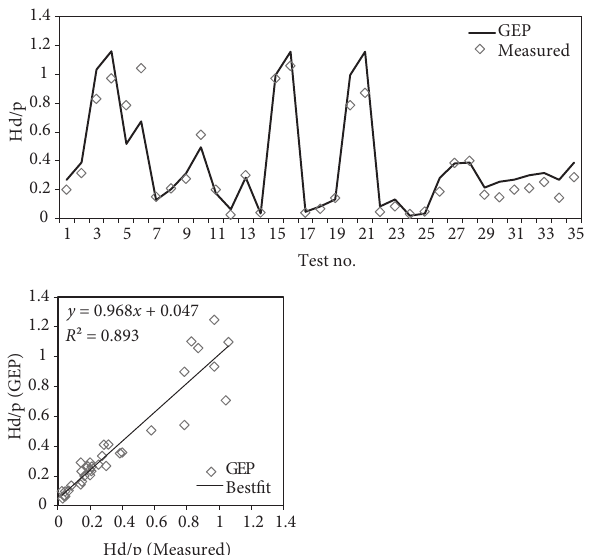
Fig. 8. GEP estimations of H set (model 1)